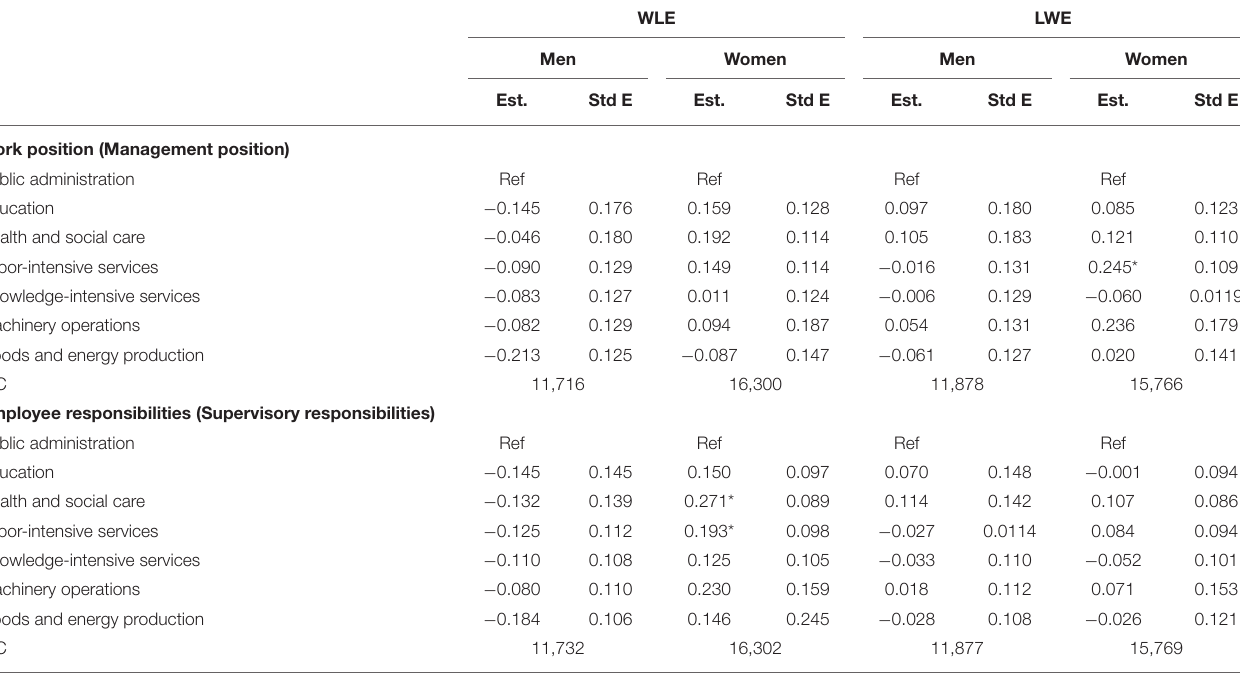
TABLE 3 | The interaction between industry and work position, respectively, and employee responsibility for men and women in work-life enrichment (WLE) and life-work enrichment